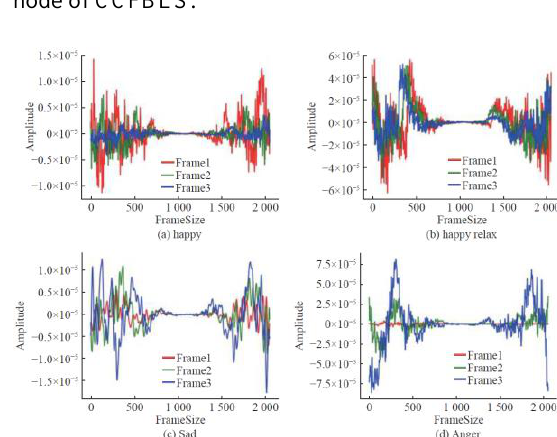
Table 1. Parameter setting